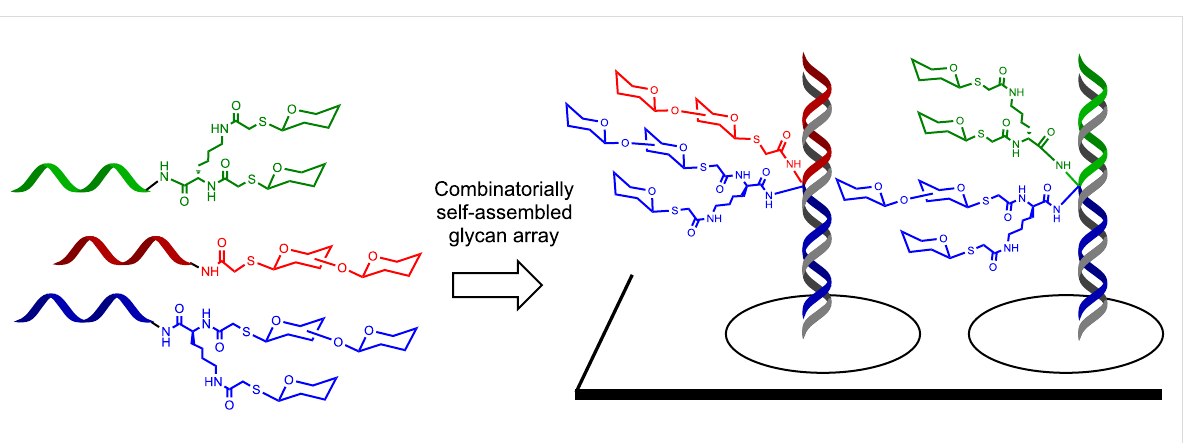
Figure 8: Combinatorial self-assembly of PNA glycoconjugates on a DNA